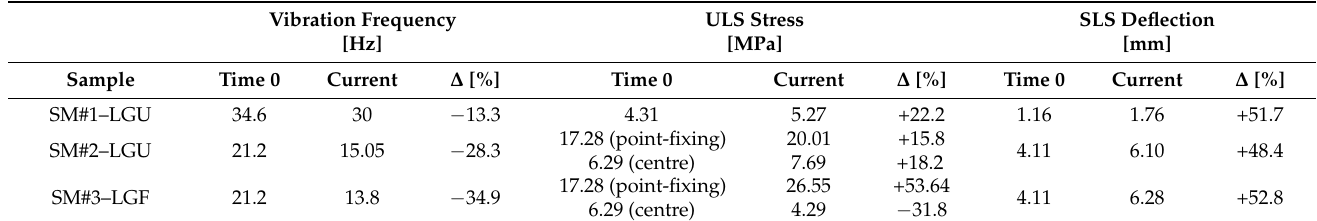
Table 5. Structural performance analysis for the examined modular units (with single occupant and M = 80 kg), with evidence of “Time 0” and “Current”